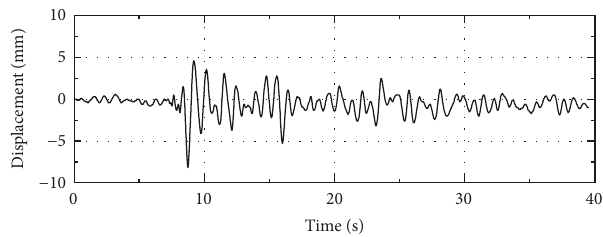
Figure 15: Displacement response curve of intensity 7 frequently of Imperial Valley (longitudinal input).